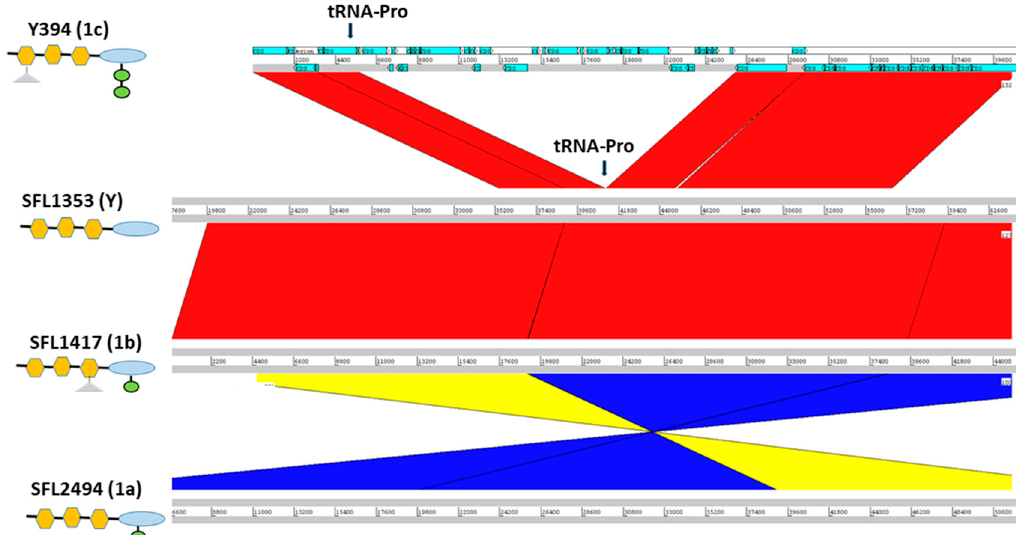
Figure 3. Cryptic SfIC phage region in S. flexneri serotypes 1c, Y, 1b and 1a from panel top to bottom, respectively. The left panel shows the strain names with the respective serotype in the parenthesis. The schematic representation of the O-antigen structure in each serotype is shown below the strain name with symbols as of Figure 1. The genomic regions are depicted as horizontal gray lines interspersed with regions of collinear (red) and inverted (yellow / blue) synteny. The blue blocks in Y394 denote the coding sequences (CDS) present. The cryptic SfIC phage region integrated within tRNA-Pro gene in Y394 is missing in serotype Y, serotype 1b and serotype 1a. However, other genes in the upstream and downstream regions of the tRNA-Pro gene are intact in serotype Y, 1b, and 1a.